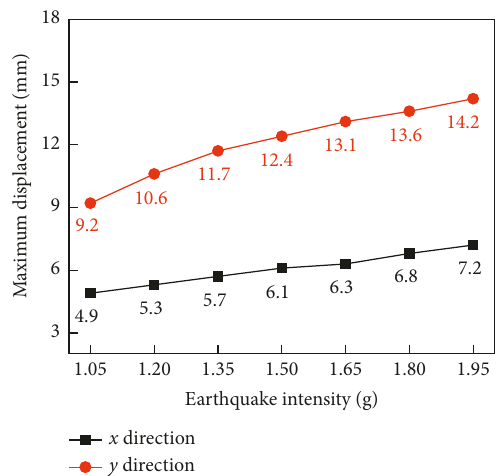
Figure 13: Comparison of maximum acceleration under different earthquake excitations.